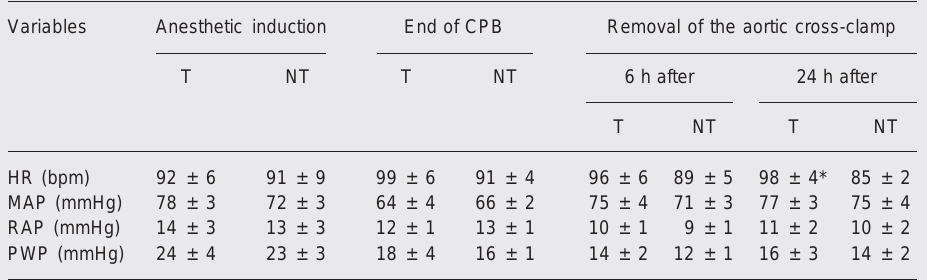
Table 2. Perioperative hemodynamic characteristics of patients treated with triiodothyronine and controls at different times during and after cardiopulmonary bypass surgery.